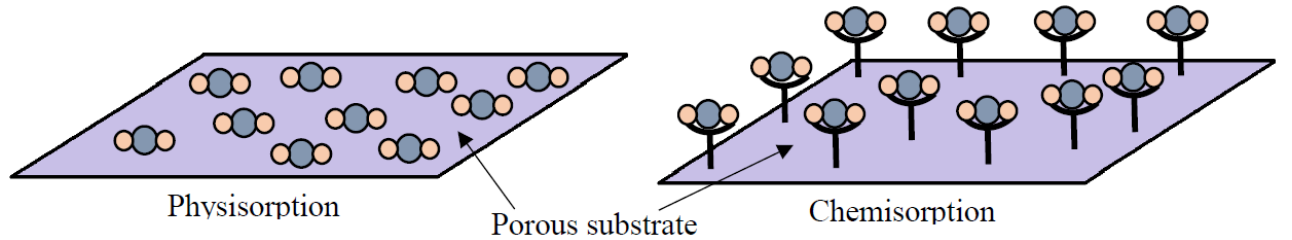
Figure 2. Schematic of the interactions between gas molecules and the adsorbent surface during physisorption and chemisorption (Reprinted with permission from ref. [26]). Table 4. Comparison of the CO 2 physisorption and chemisorption processes.